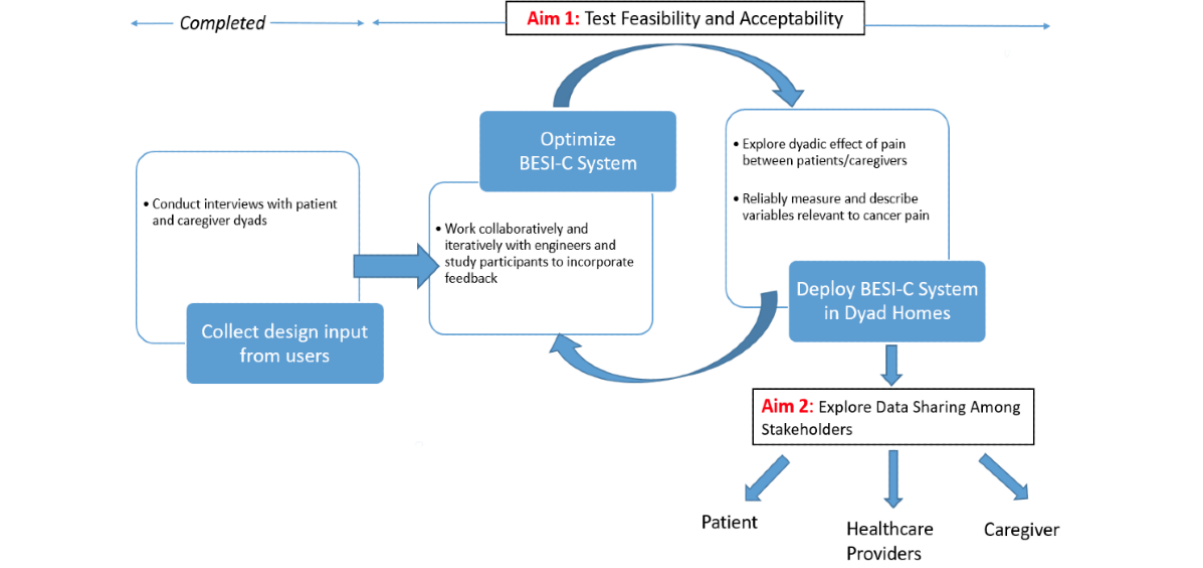
Figure 1. Overall study design. BESI-C: Behavioral and Environmental Sensing and Intervention for